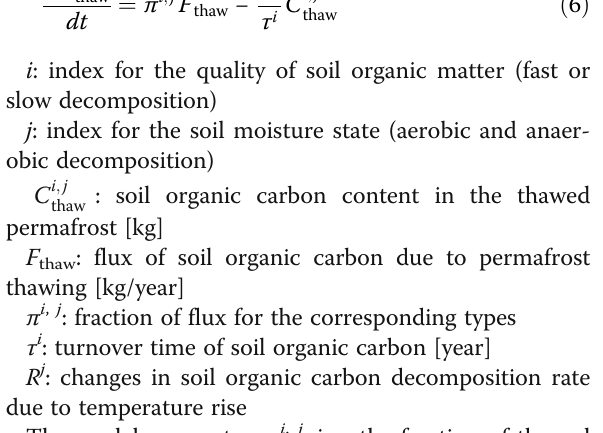
Table 2 Volume fraction of air bubbles in the ground ice and frozen soil ( R pore ) and the concentration of GHGs in the air bubbles ( C GHG ) Variable CO 2 /ground ice CH 4 /ground ice CO 2 /frozen soil CH 4 /frozen soil